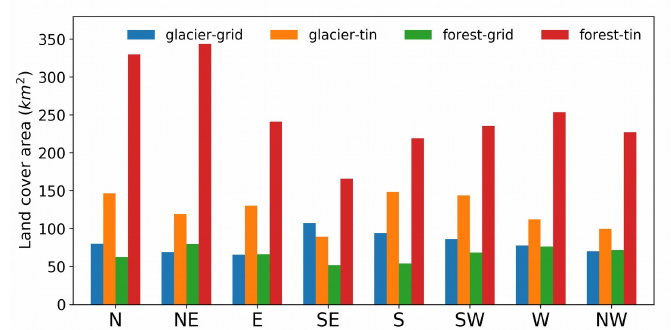
Figure 11. Land type distribution in Marsyangdi_2 river catchment from TIN and